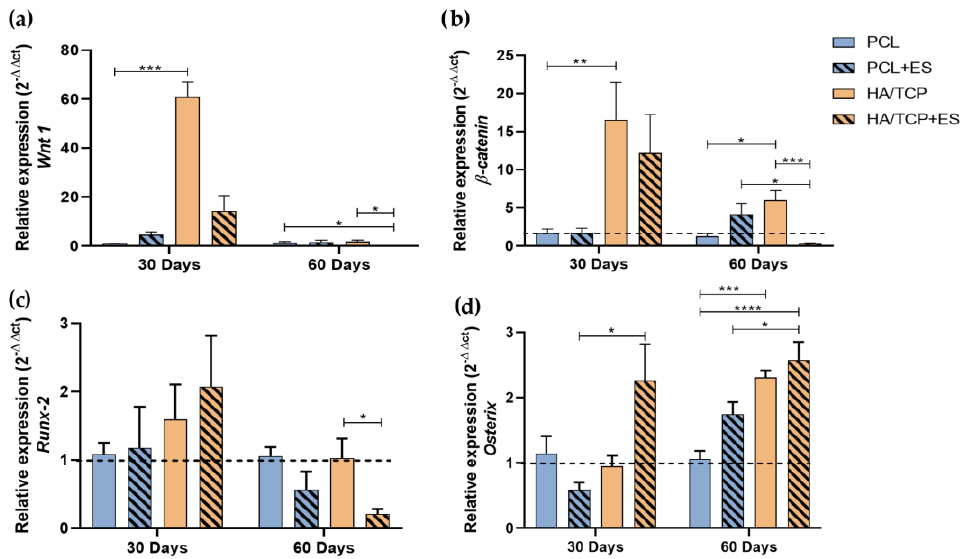
Figure 2. Relative expression of ( a ) Wnt 1 , ( b ) β -catenin , ( c ) Runx-2 and ( d ) Osterix (2 − ∆∆ ct ). Results were expressed as mean ± standard error of the mean (significance levels were established in * p < 0.05, ** p < 0.01, *** p < 0.001, **** p < 0.005).